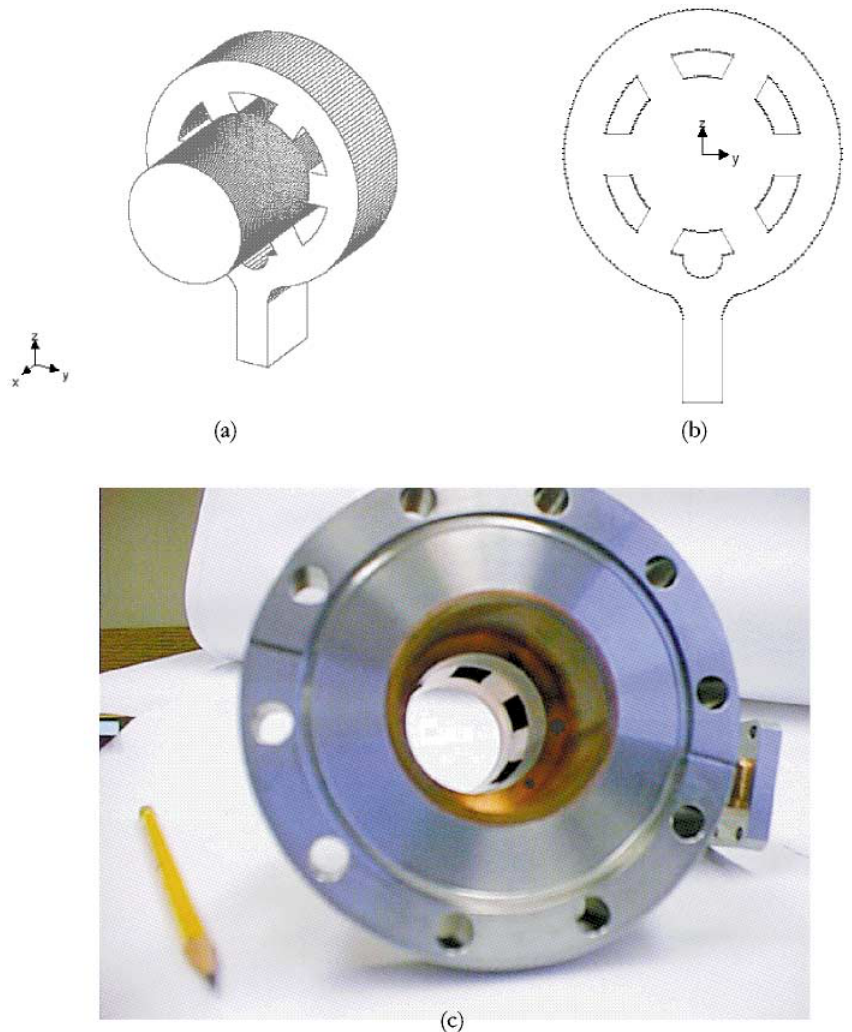
FIG. 12. (Color) The wrap-around mode converter. The physical model shown in the picture does not have the back wall shorting plate. This is done for illustration purposes